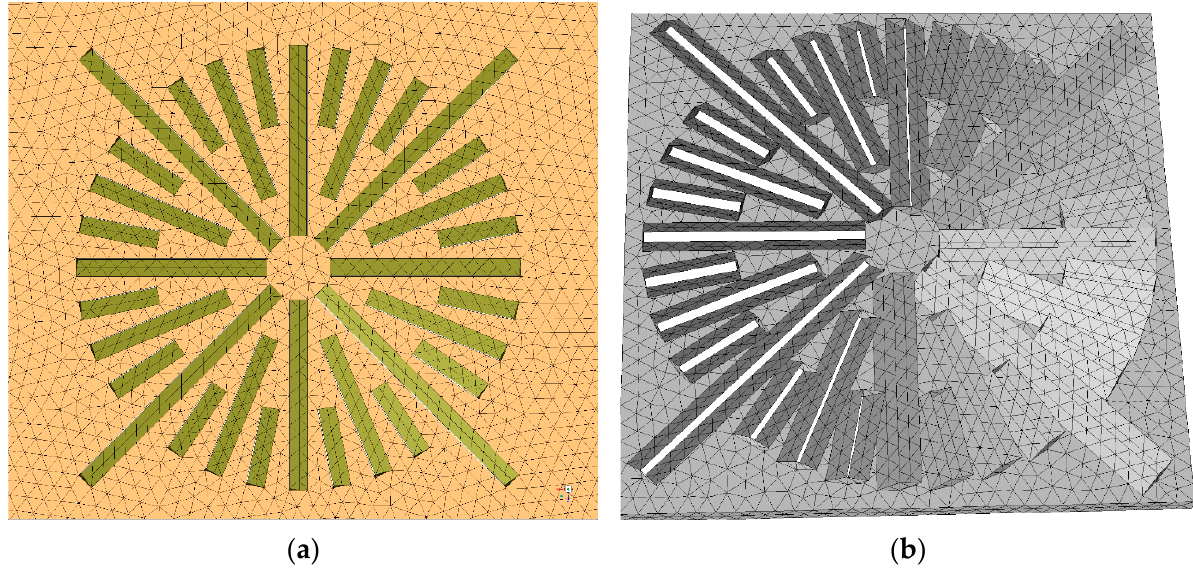
Figure 6. Mesh discretization of the swirl ceiling diffuser. ( a ) 2D view. ( b ) 3D view. Numerical models generally use discrete methods to convert the governing